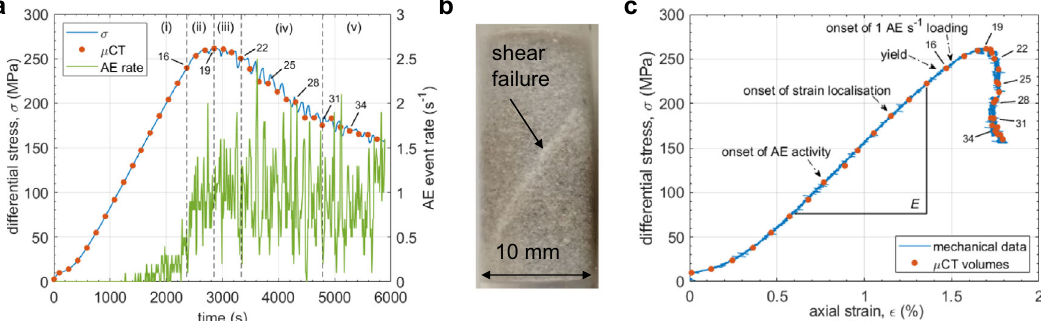
Fig. 1 | Bulk mechanical behaviour of Clashach sandstone. a Evolution of dif- ferential stress, σ (blue line), and acoustic emission (AE) event rate, _ N (green line), with time. Orange circles denote the times of the X-ray tomographic volumes. The plottedAEeventratewascalculatedfromallrecordedevents,binnedinto10stime intervals. Consistent with previous studies 75,76 , we identi fi ed fi ve stages of defor- mation:(i)initialcompactionandthenquasi-elasticbehaviouruptotheyieldpoint, (ii)strainhardeningapproaching peakstress, σ P ,(iii)damage zonelocalisationand strain softening beyond σ P , (iv) sample weakening due to shearzone development through the sample and (v) shear sliding along a contiguous sub-planar fault. The transition from constant strain rate loading (10 − 5 s − 1 ) to constant AE event rate loading (1±1 AEs − 1 ) occurredearly in stage(ii) shortlyafterthe sampleyield point, which was de fi ned by the point at which the stress-strain curve deviated from linearityandtheAEeventrateacceleratedbeyondthesteadybutlowrateobserved duringtheelasticregion(linearportionofthestress-straincurve). b Photographof